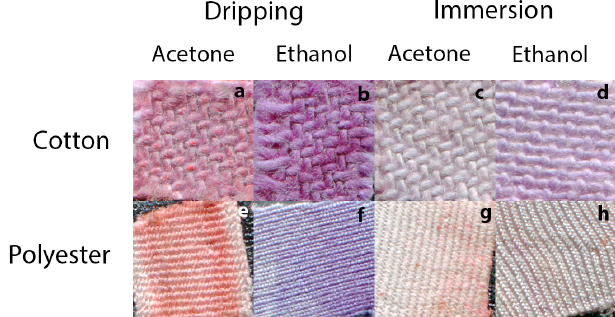
Figure 3. Swatches of dyed fabrics, showing the color change from the dramada pigment across fabric and solvent: ( a ) acetone dye on cotton, applied through dripping; ( b ) ethanol dye on cotton applied through dripping; ( c ) acetone dye on cotton applied through immersion; ( d ) ethanol dye on cotton applied through immersion; ( e ) acetone dye on polyester applied through dripping; ( f ) ethanol dye on polyester applied through dripping; ( g ) acetone dye on polyester applied through immersion; ( h ) ethanol dye on polyester applied through immersion.